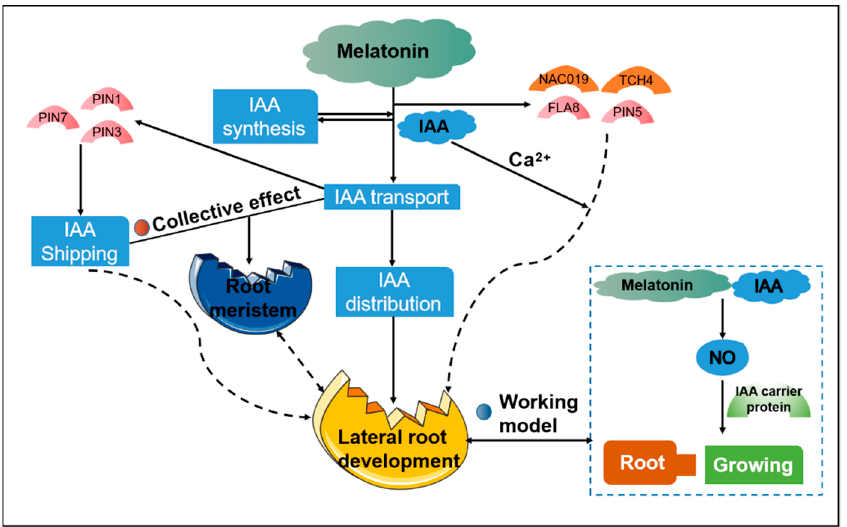
Figure 4. Regulation of IAA signaling by melatonin include key components and transcriptional regulation.